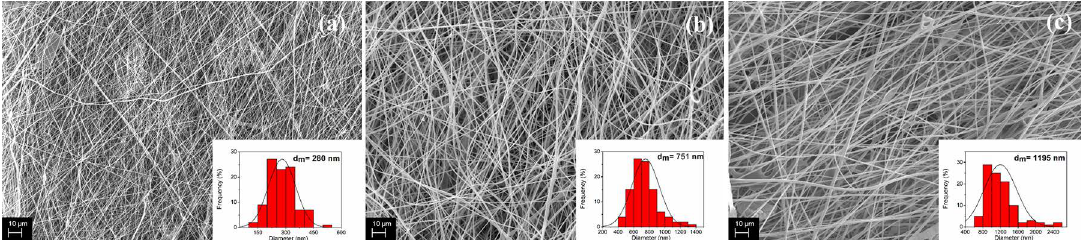
Figure 1. Fish gelatin Microfibers Scanning Electron Microscope (SEM – 1000x zoom) of the sample at varius concentrations: (a) 15% (w/v); (b) 20% (w/v); (c) 25%